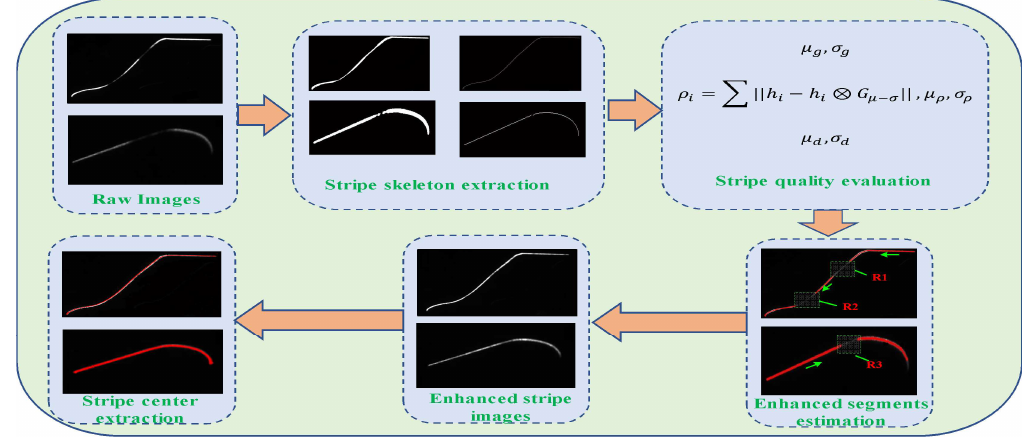
Figure 3. Diagram of stripe image enhancement in highly reflective conditions.